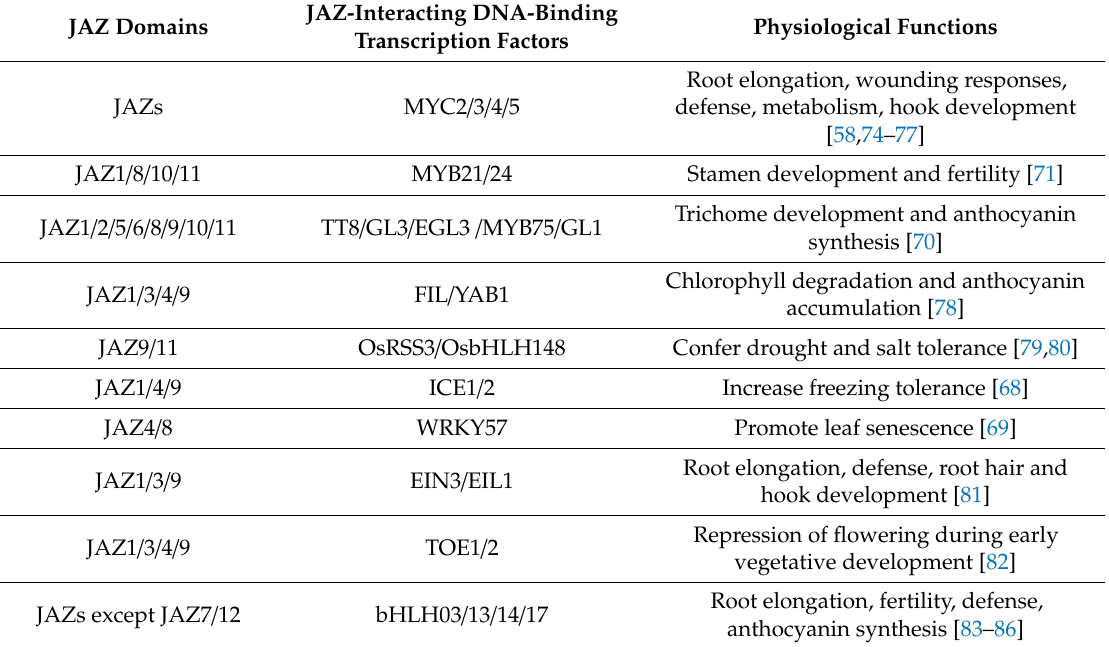
Table 1. Transcription factors that interact with the jasmonate-ZIM domain proteins and their corresponding JA-regulated plant responses (adapted from Zhai et al. [72]; Zhu and Lee [73]). JAZ-Interacting DNA-Binding Physiological Functions JAZ Domains Transcription Factors Root elongation, wounding responses, JAZs MYC2 / 3 / 4 / 5 defense, metabolism, hook development [58,74–77] JAZ1 / 8 / 10 / 11 MYB21 / 24 Stamen development and fertility [71] Trichome development and anthocyanin JAZ1 / 2 / 5 / 6 / 8 / 9 / 10 / 11 TT8 / GL3 / EGL3 / MYB75 / GL1 synthesis [70] Chlorophyll degradation and anthocyanin JAZ1 / 3 / 4 / 9 FIL / YAB1 accumulation [78] JAZ9 / 11 OsRSS3 / OsbHLH148 Confer drought and salt tolerance [79,80] JAZ1 / 4 / 9 ICE1 / 2 Increase freezing tolerance [68] JAZ4 / 8 WRKY57 Promote leaf senescence [69] Root elongation, defense, root hair and JAZ1 / 3 / 9 EIN3 / EIL1 hook development [81] Repression of flowering during early JAZ1 / 3 / 4 / 9 TOE1 / 2 vegetative development [82] Root elongation, fertility, defense, JAZs except JAZ7 / 12 bHLH03 / 13 / 14 / 17 anthocyanin synthesis [83–86] JA, jasmonic acid; JAZ, jasmonate ZIM